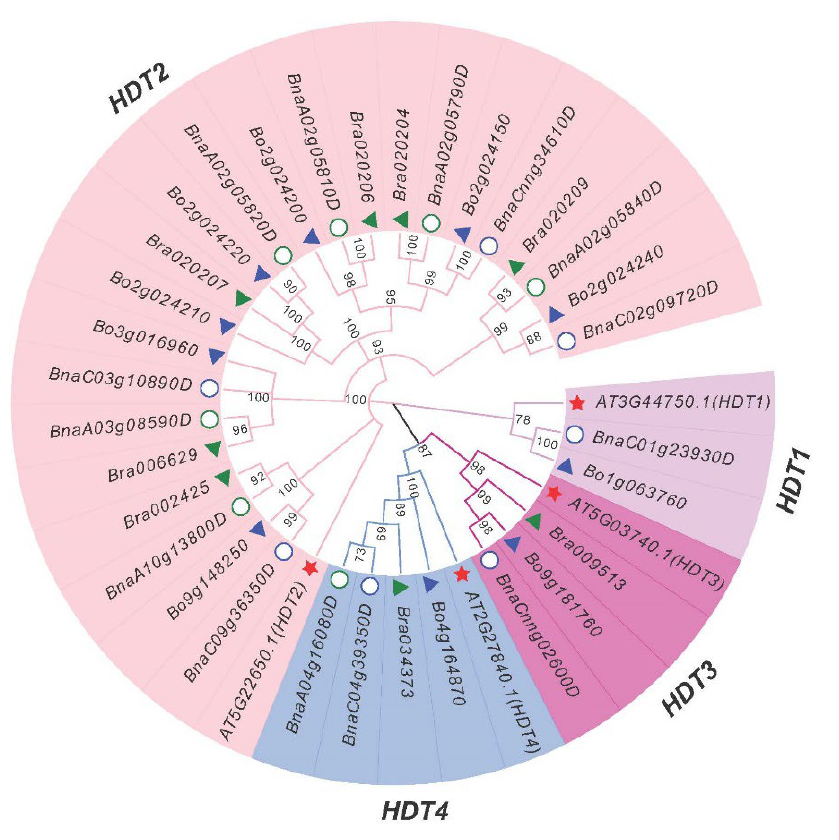
Figure 1. Phylogenetic analysis of 36 HDT proteins from B. napus (14), B. rapa , (8), B. oleracea (10) and Arabidopsis (4).